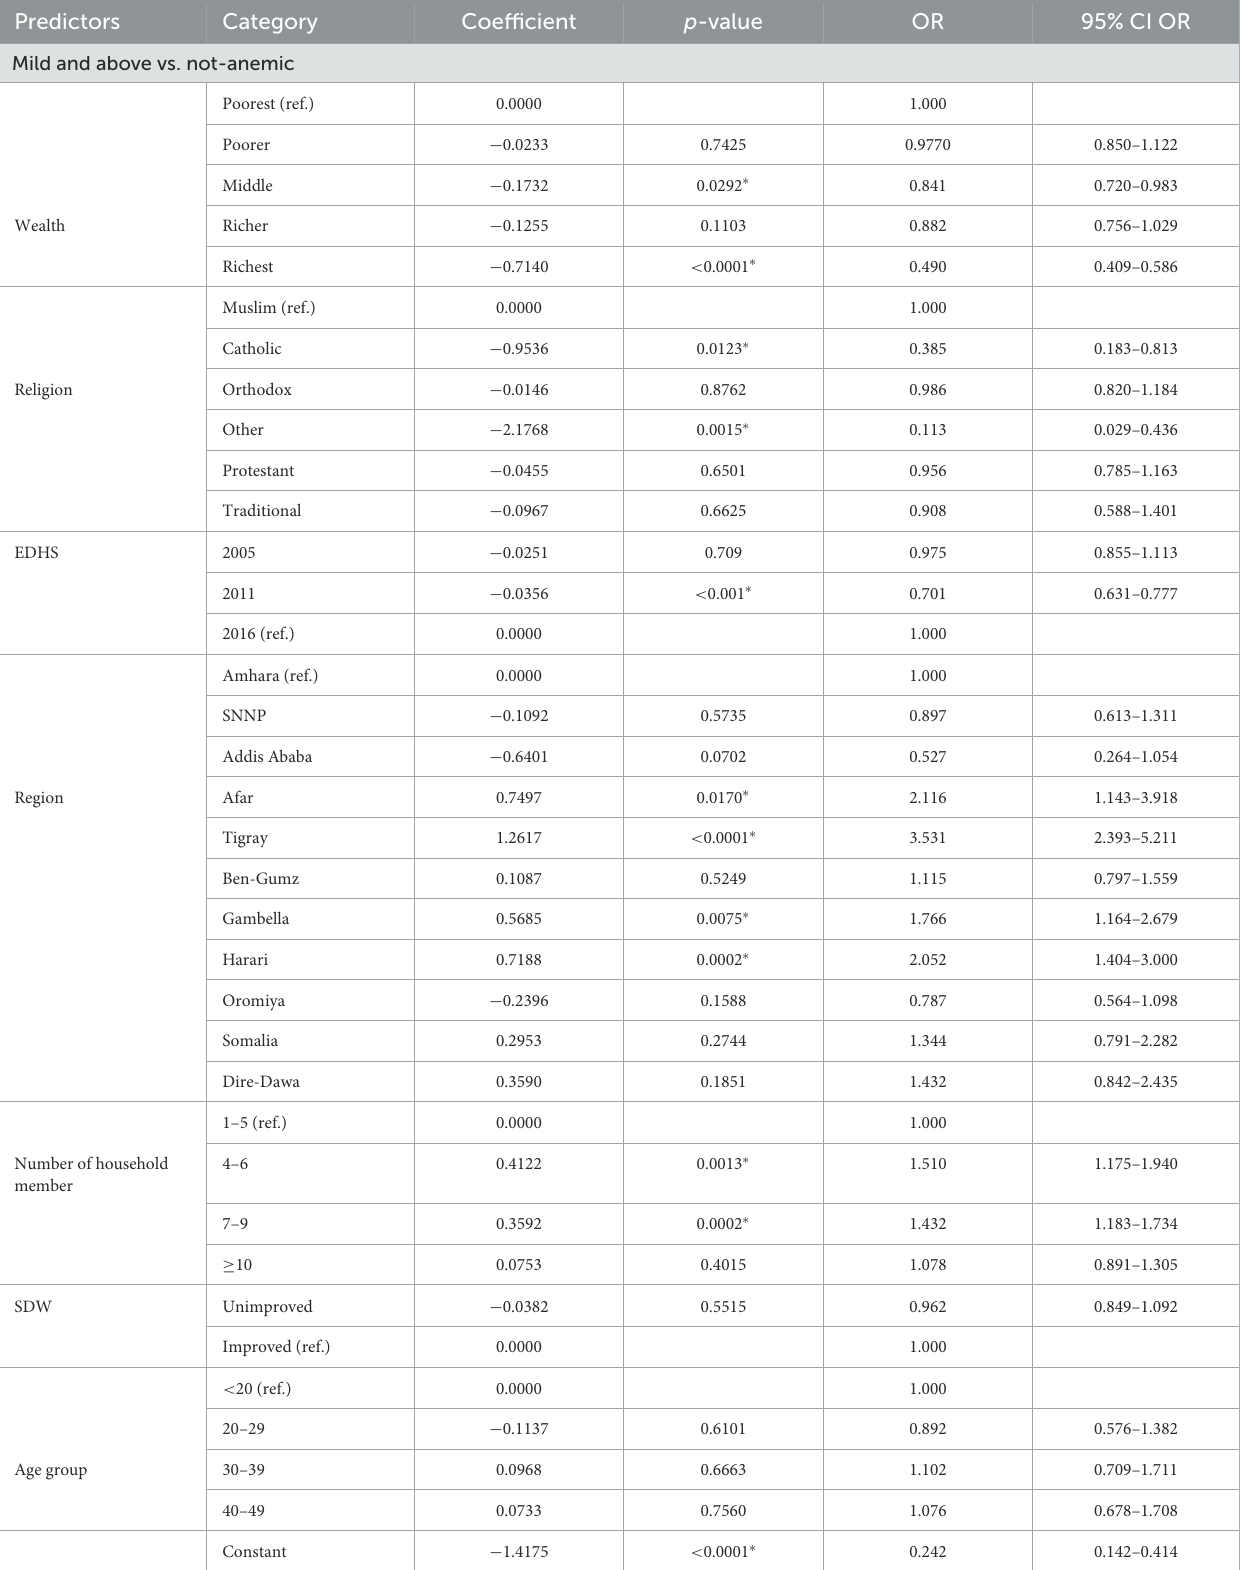
TABLE 7 Maximum likelihood estimates of partial proportional odds model. Predictors Category Coefficient p